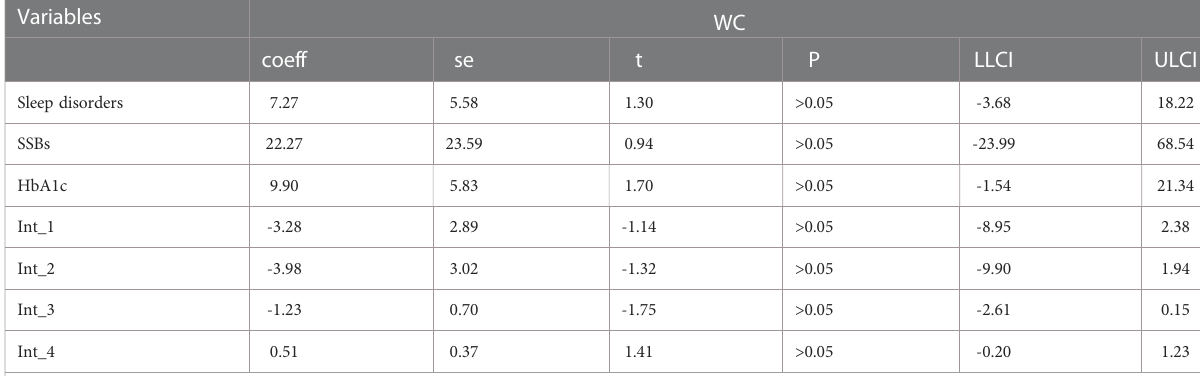
TABLE 7 The moderation analysis between SSBs, Sleep disorders, HbA1c and WC. Variables